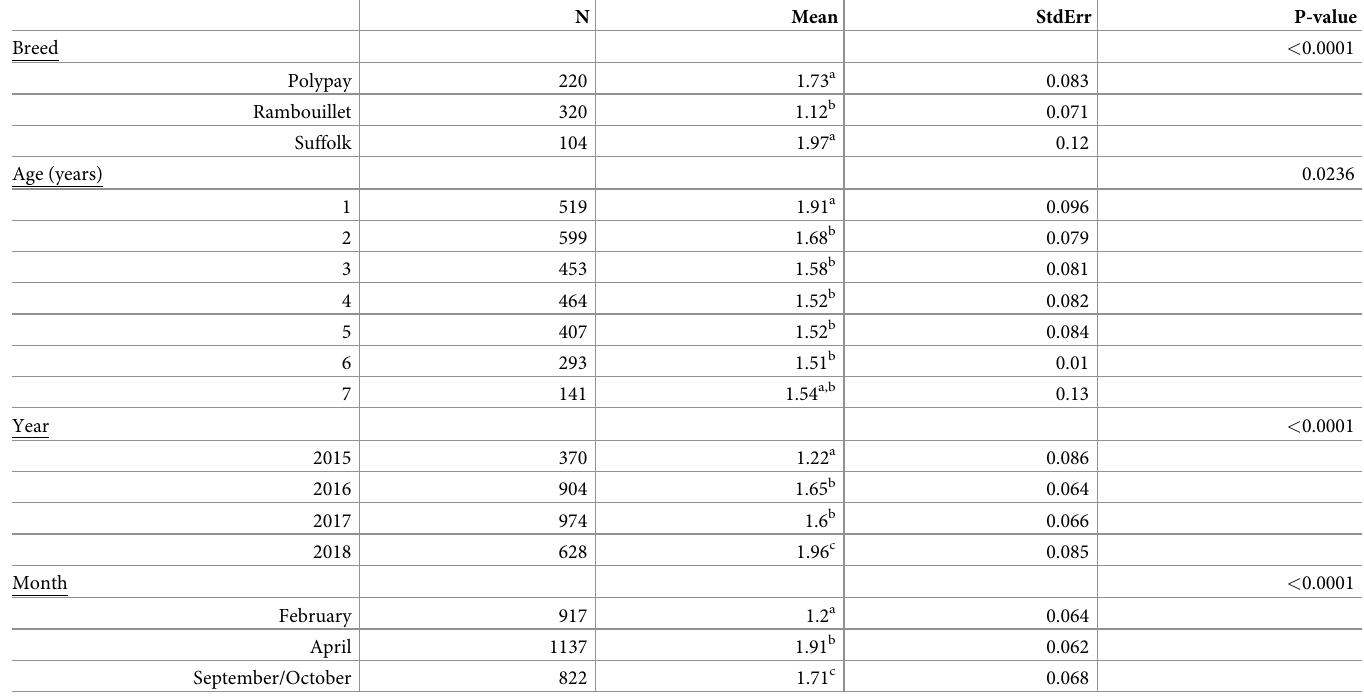
Table 1. Mean M . ovipneumoniae log 10 transformed DNA copy number in breed and age of ewes; year and month of sample